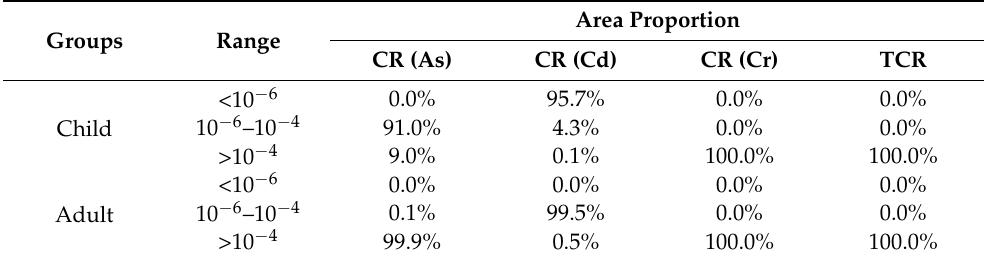
Figure 6. Health risk distribution of heavy metals in groundwater. ( A ) carcinogenic risk ( B ) non- carcinogenic risk. Table 6. Area proportion of carcinogenic risk.